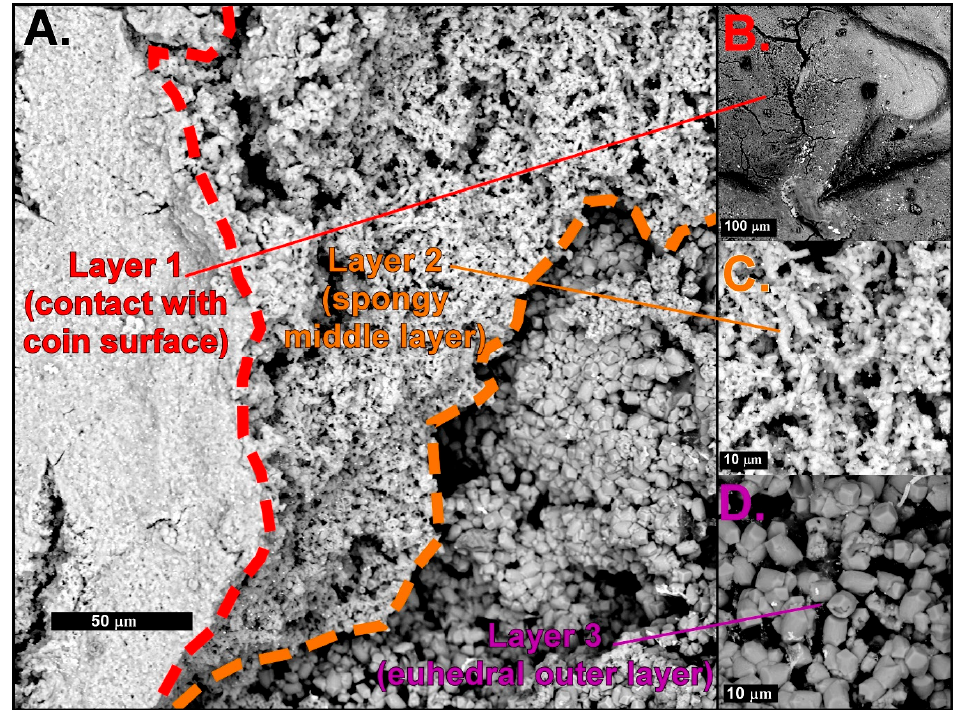
Figure 5. SEM images of the three distinct layers within black crusts at 1,100×: coin surface, biomat layer, and outer layer. ( A ) Exposed section of the three layers along a natural fracture, ( B ) layer 1 with letter imprint from coin surface (630×) and crypto-crystalline iron oxides (grey), ( C ) middle layer 2 with spongy growths of iron oxides (grey), and ( D ) surface layer 3 with euhedral iron sulfate minerals (dark grey) ( C and D ; both 5,900×).